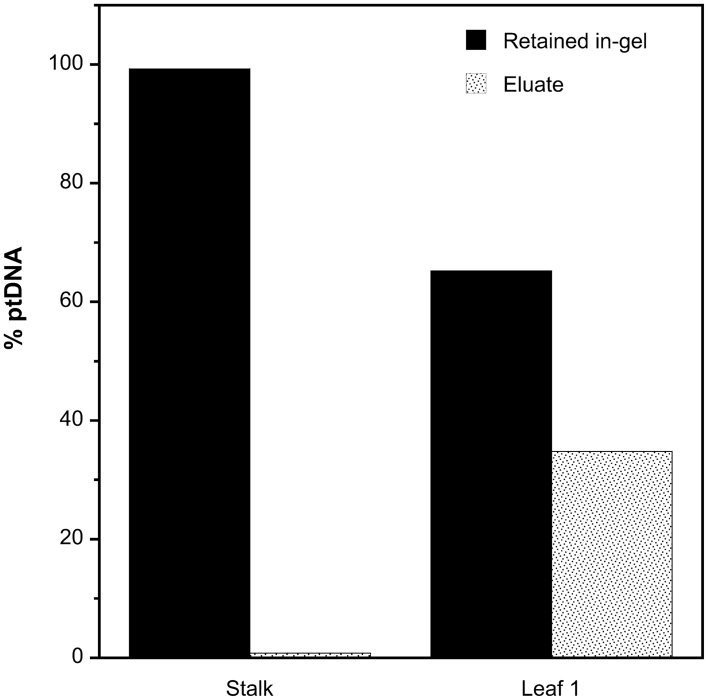
Amount of ptDNA retained in gel and eluted from the gel. Plastids were isolated from the entire stalk and leaf 1 of 14-d-old light-grown plants, then embedded in agarose, treated with lysis solution, and washed with TE buffer (see Materials and methods). The ptDNA that diffused out of the agarose was recovered from the lysis and wash solutions (eluate). The ptDNA copy number for the in-gel and eluate fractions was determined using qPCR and is given as percentage of total chloroplast DNA from both fractions. Three technical replicates were used per sample.